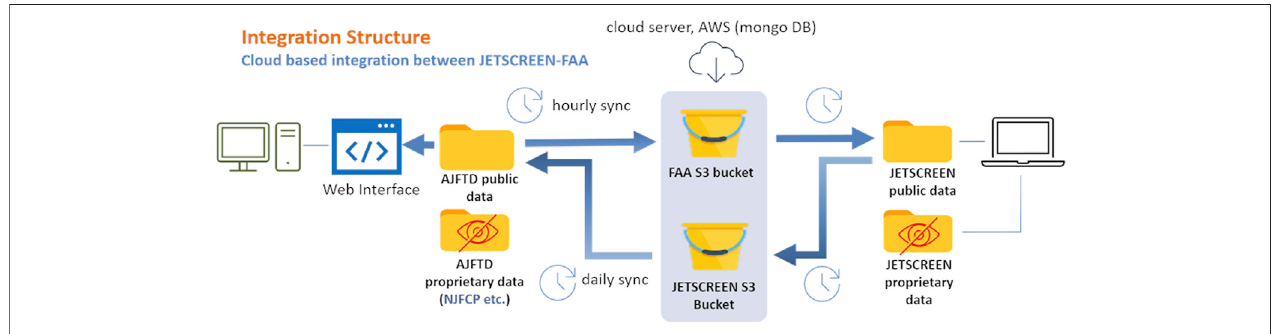
FIGURE 2 | Overview of database integration between JETSCREEN and FAA